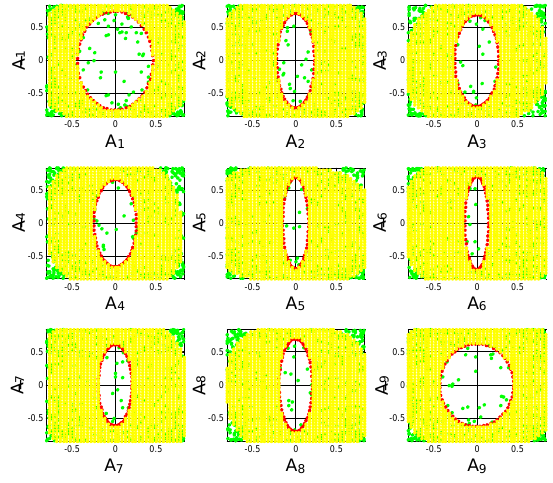
Fig. 6. Confidence evaluation for the ROA of IEEE 39 bus system with 400 sampling points. In each panel, the green dots denote the stable sampling points, and the red dashed ellipse represents the boundary of a certified ROA. The yellow region indicates the states that converge to the origin with the probability of at least